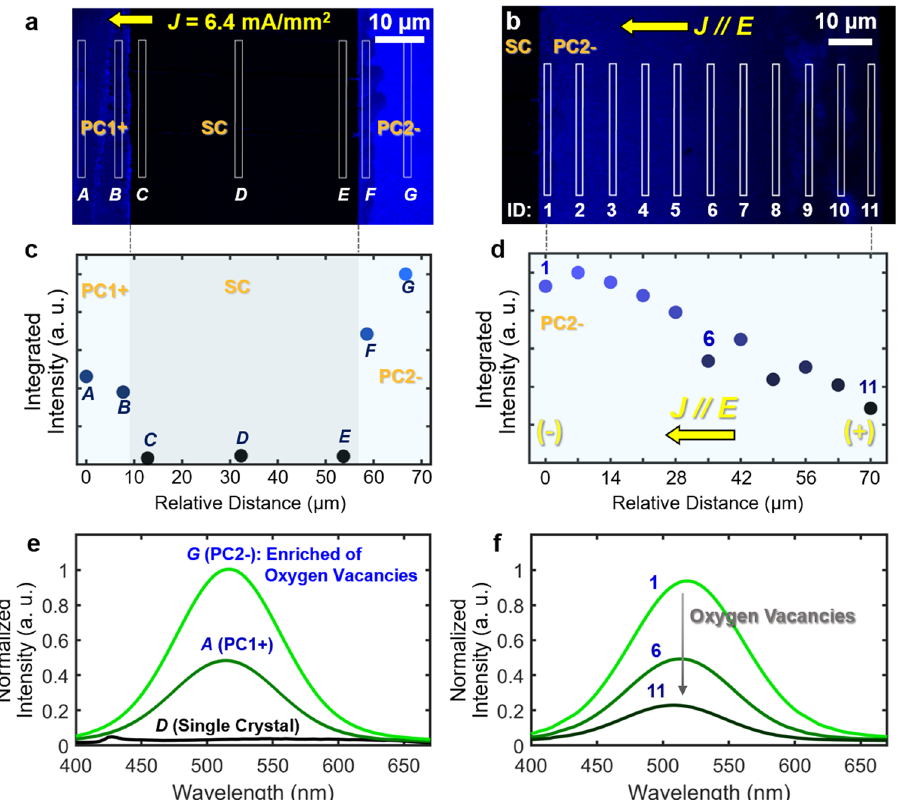
Fig. 3 Photoluminescence spectroscopy of the sandwich specimen annealed with a constant applied electric current, suggesting the enrichment of oxygen vacancies in the reduced PC2 – region. a , b Maps of the photoluminescence intensity at the 526 nm wavelength of the cross-sectional PC1/SC/ PC2 sandwich specimen. c , d Integrated photoluminescence intensities for the combined photoluminescence peak at ~400 – 700 nm at different locations, representing all defects at GBs. Photoluminescence spectra are collected at Locations A – G labeled in a and Locations 1 – 11 labeled in b , respectively. e , f The normalized photoluminescence intensity vs. wavelength curves of decomposed green-emission band (representing the oxygen vacancy concentration) at selected locations. See Supplementary Note 4 and Supplementary Fig. 8 for further detail. In c – f , a.u. stands for arbitrary unit.